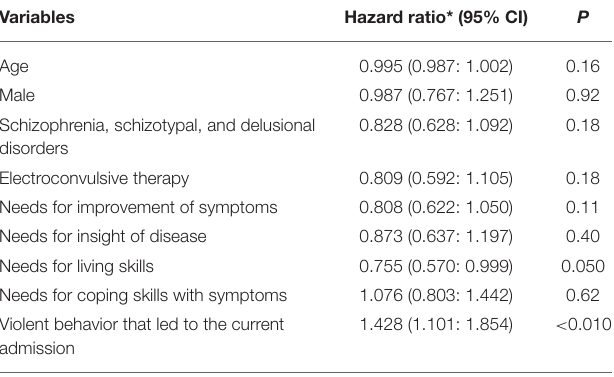
TABLE 3 | Cox proportional multivariate hazard